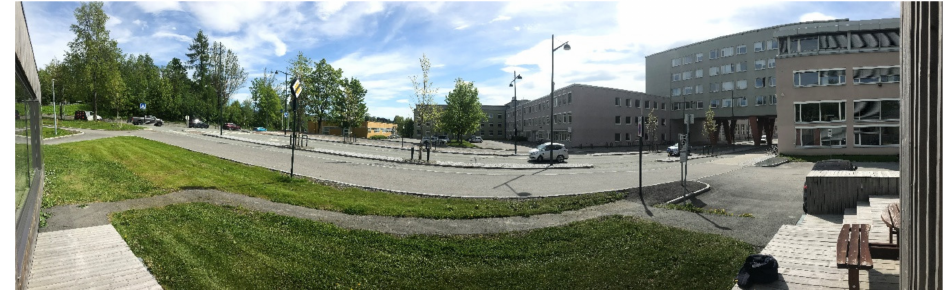
Figure 15. Panoramic view from a vertical sensor positioned south, ZEB Living Lab, NTNU Campus.